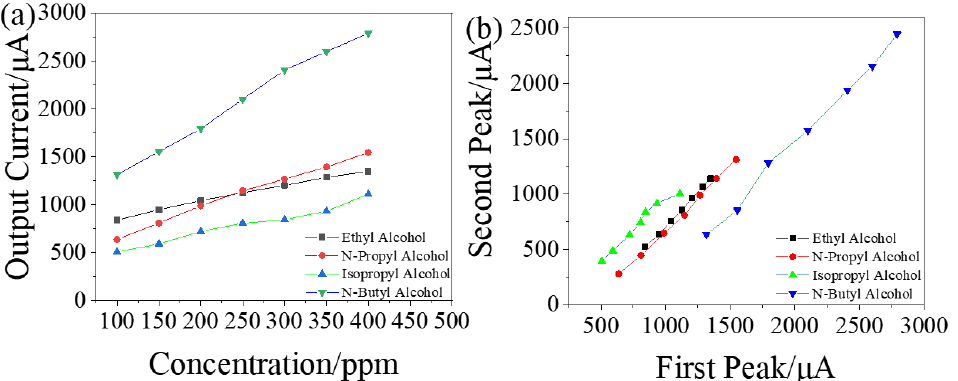
Figure 6. ( a ) The concentration gradient diagram of peak gas concentrations of four alcohol homo- logues under TW-1 ( b ) The first peak and secondary peak concentration gradients of four alcohol homologues under TW-1.